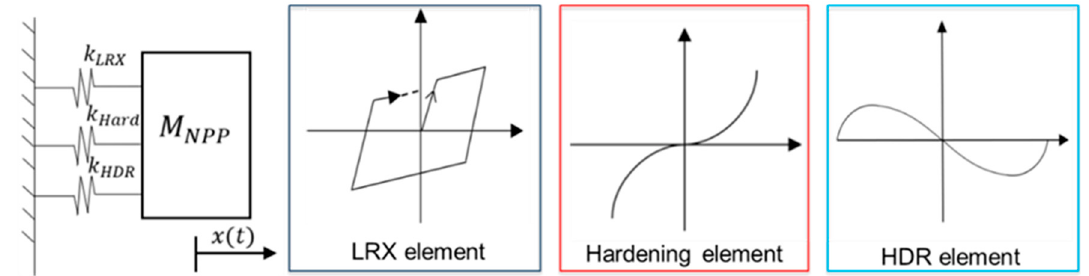
Figure 4. Parallel system of the bearing model [19].